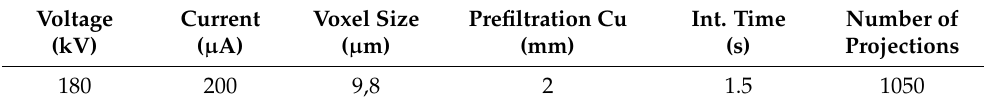
Table 2. Scan parameters for the XCT analysis.